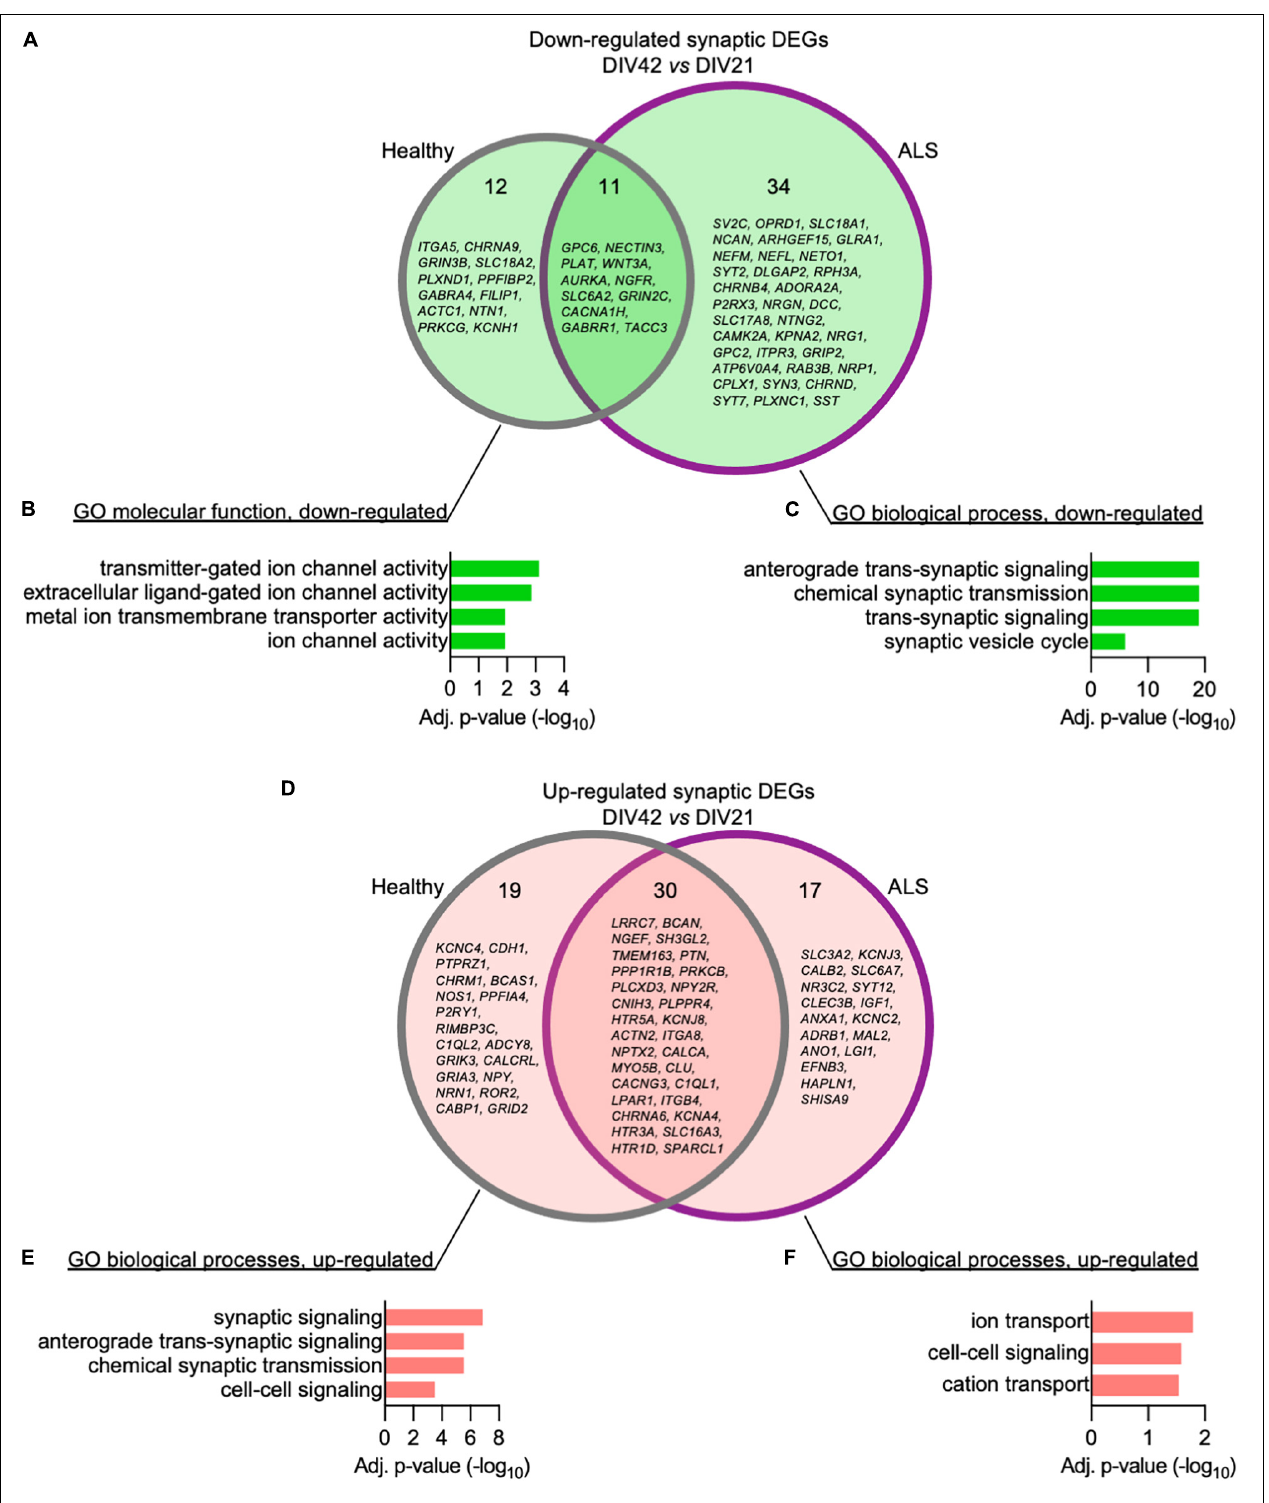
FIGURE 5 | The time-dependent loss of synaptic transcripts in ALS C9orf72 motor neurons mainly affects the neurotransmitter vesicle release machinery. (A) Venn diagram showing the genotype-specific synaptic DEGs whose expression decreases over time. (B) Corresponding enrichment analysis performed for Healthy and (C) ALS C9orf72 MN. (D) Venn diagram showing the genotype-specific synaptic DEGs whose expression increases over time. (E) Corresponding enrichment analysis performed for Healthy and (F) ALS C9orf72 MN.